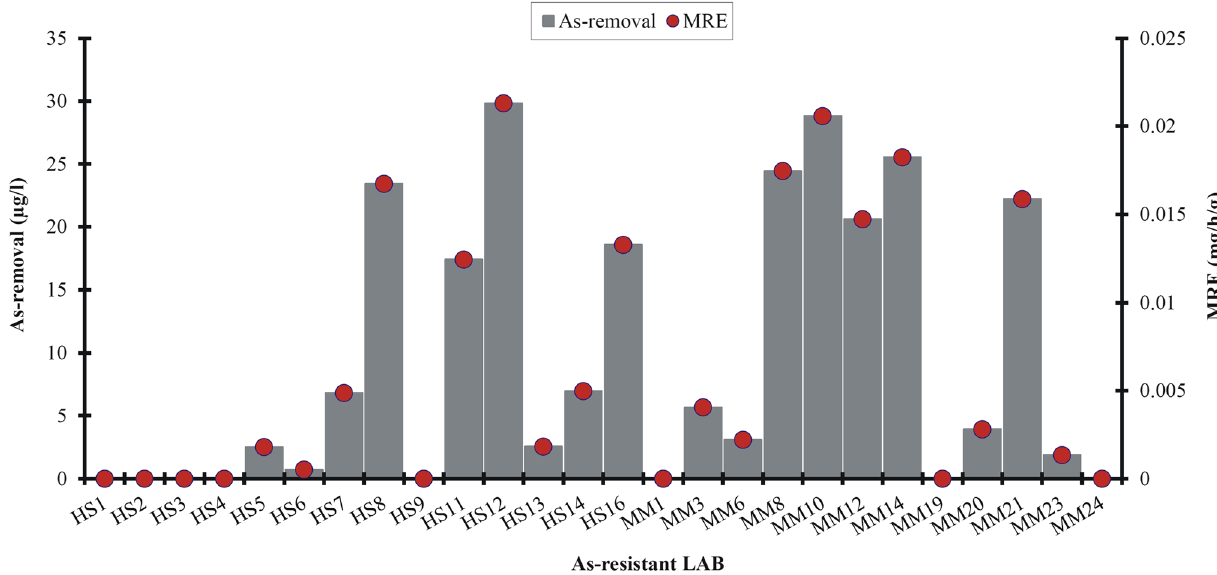
Fig. 1 Arsenic removal and MRE properties of As-resistant LAB isolates from As supplemented (100 mg/l) aqueous